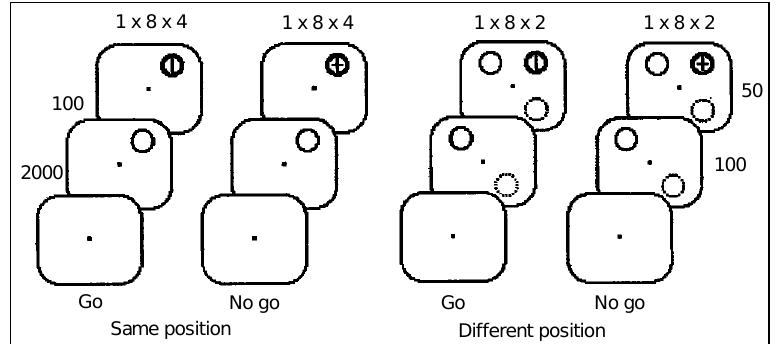
Figure 1. Spatial position and temporal order of appearance of the fixation point, the prime stimulus and the target stimuli in the same condition and the different condition. The mean interval between the appearance of the fixation point and the prime stimulus onset was 2000 ms. Stimulus onset asynchrony was 100 ms. The prime stimulus (continuous and dotted contour rings, respectively, actual and alternative positions) lasted either 100 ms or 150 ms. The target stimuli (vertical line inside a ring and cross inside a ring) lasted 50 ms. Numbers above the upper frames refer to number of sessions, number of blocks per session and number of trials of each condition per